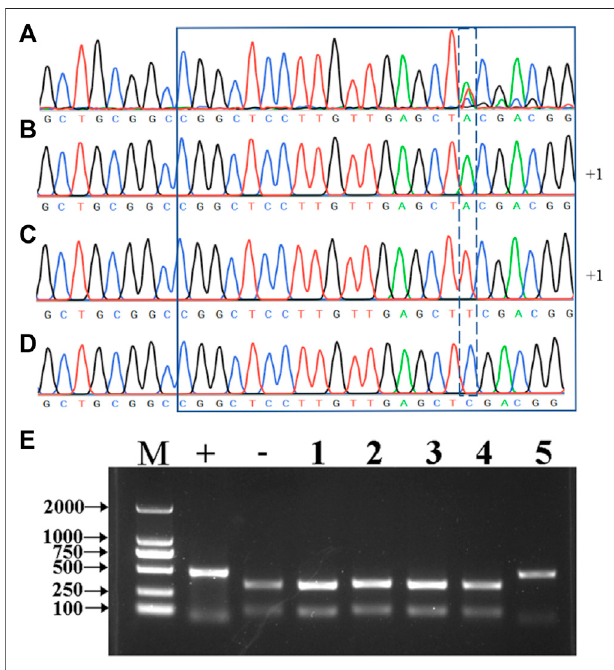
FIGURE 3 | (A) Sequencing of the edited sites of the HvNud gene using the PCRproductsofBL2. (B – D) Sequencing byusing thesubclonings ofBL2 PCR products on the vector. (E) Detection of HvNud -edited mutations in different tillers of Ha3 in T 0 generation by PCR-RE. M: DNA marker; +: positive control; -: negative control; 1 – 5: fi ve different tillers of